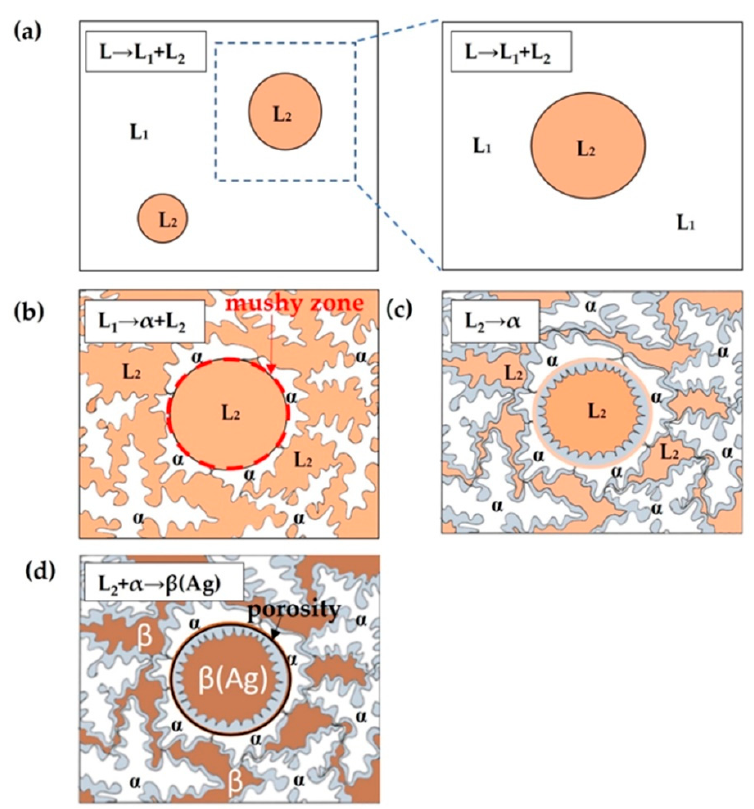
Figure 10. Proposed model of solidification of CCNA ( a ) Liquid phase separation (L → L 1 + L 2 ) ( b ) Monotectic reaction L1 → α + L 2 ( c ) L 2 → α solidification of coat ( d ) Peritectic solidification.